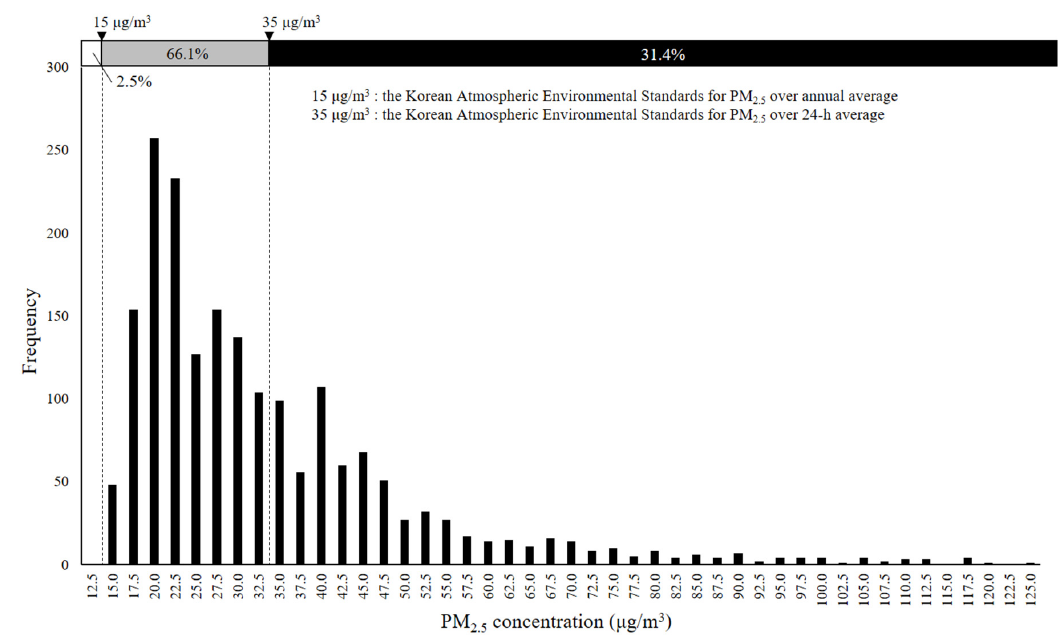
Figure 10. Histogram of population-weighted average exposure concentrations of PM 2.5.